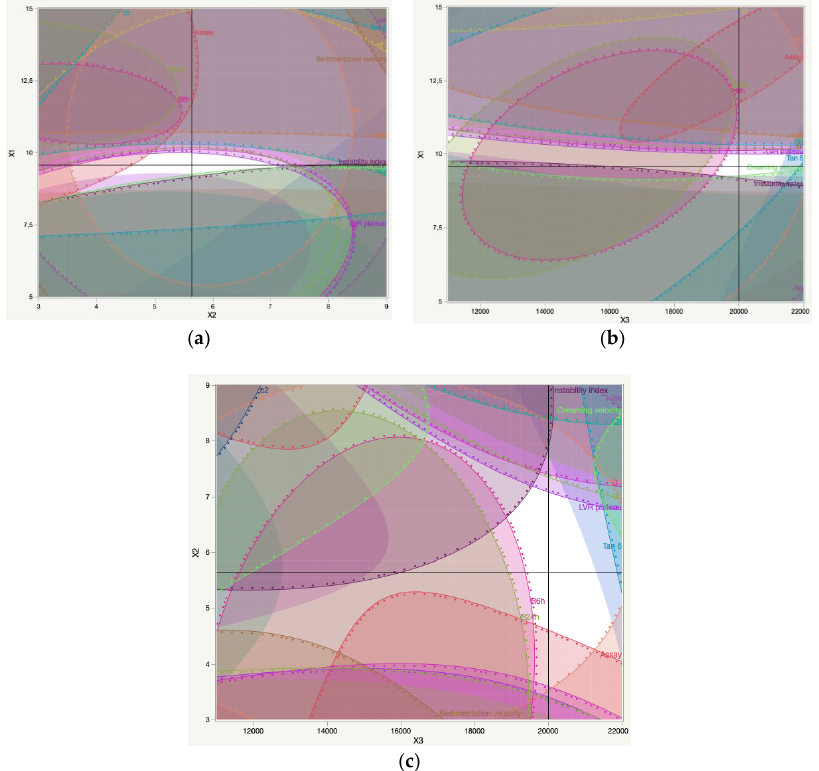
Figure 8. Design space of glycerol monostearate content, isopropyl myristate content and homogenization rate, comprising the overlay of ( A ), ( B ) and ( C ) optimal regions.